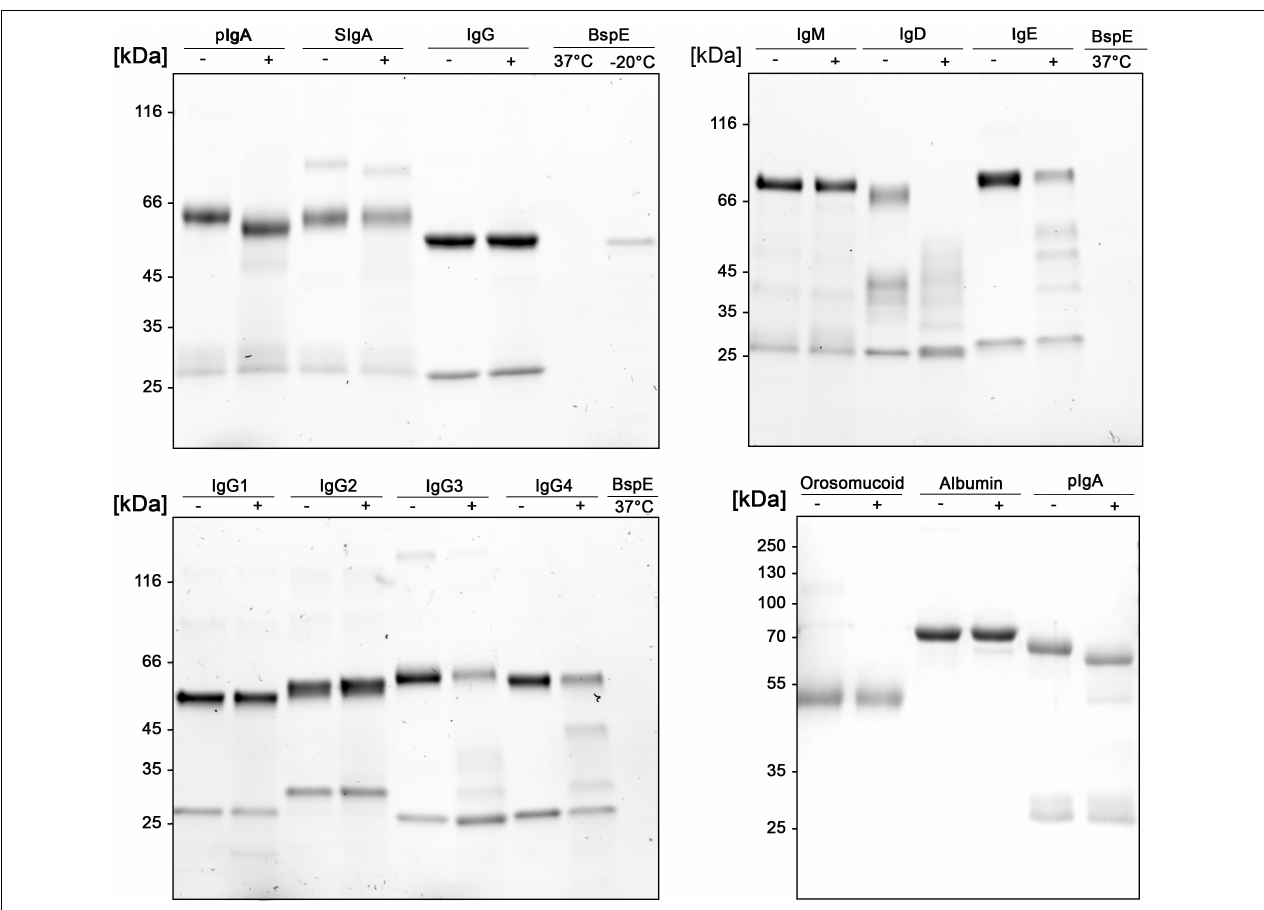
FIGURE 5 | Native human immunoglobulins are not general BspE substrates. Native human immunoglobulins including: IgA, SIgA, IgE, IgD, IgM, and all the IgG subclasses were incubated with BspE (37 ◦ C, o/n), + and – denotes presence and absence of BspE. Analysis by SDS-PAGE under reducing conditions.